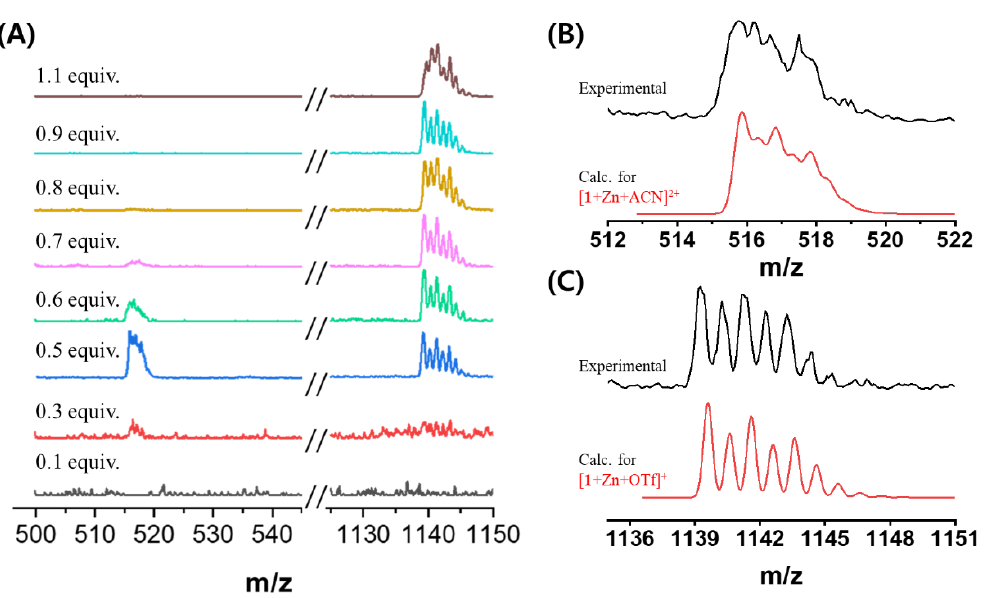
Figure 3. ( A ) Electrospray ionization (ESI)-mass spectra of 1 (0.1 mM) in the various equiv. of Zn 2 + in ACN. Experimental and calculated data of ( B ) [ 1 + Zn + ACN] 2 + and ( C ) [ 1 + Zn + OTf] + .